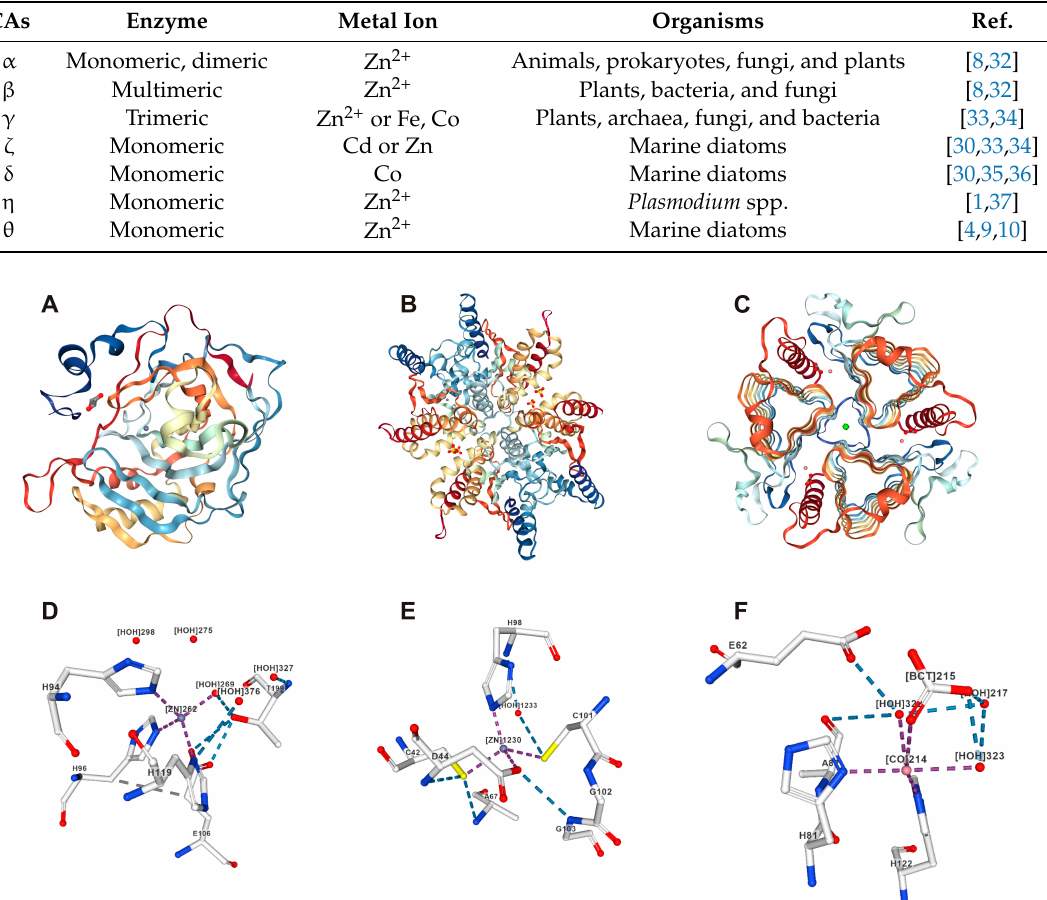
Table 1. Details of the carbonic anhydrase (CA) gene family enzymes in living organisms.